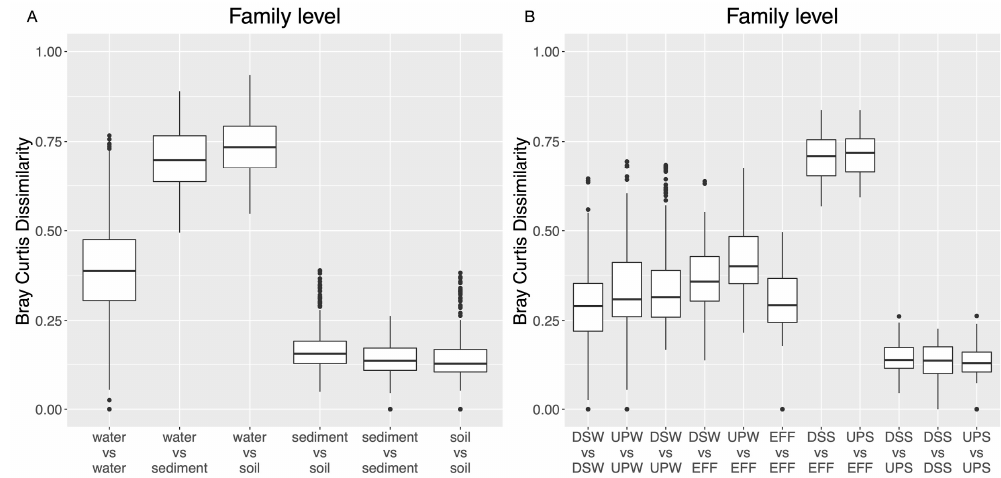
Figure 3. Principal coordinate plot of urban stream communities including wastewater treatment plants showing differences between sample types ( A ) and geographical location in the river system and wastewater treatment plant ( B ). Numbers in parentheses are the percent variance explained by each axis.